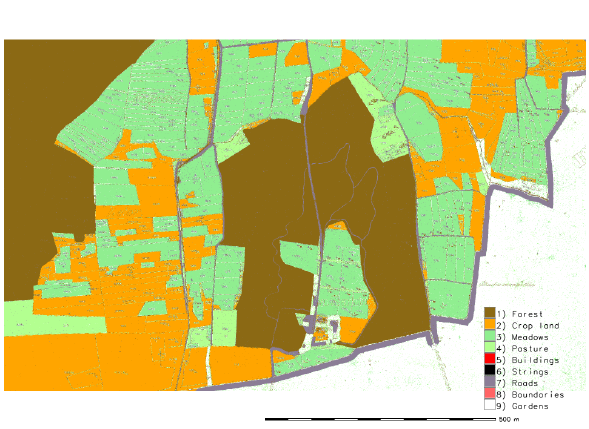
Figure 11. Classified map for OBIA and BWWV after text and symbols removal - particular.